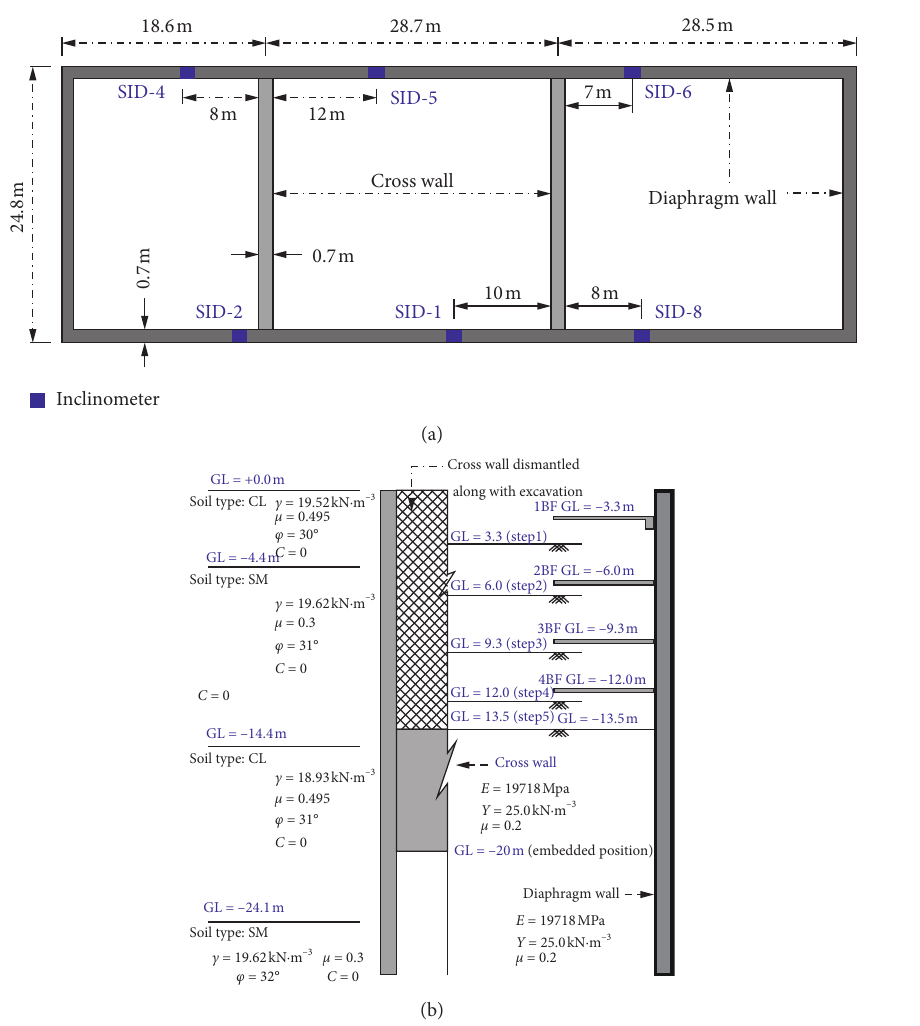
Figure 7: Excavation geometry and stratigraphy. (a) Cross wall geometry and monitoring layout. (b) Excavation and subsurface soil